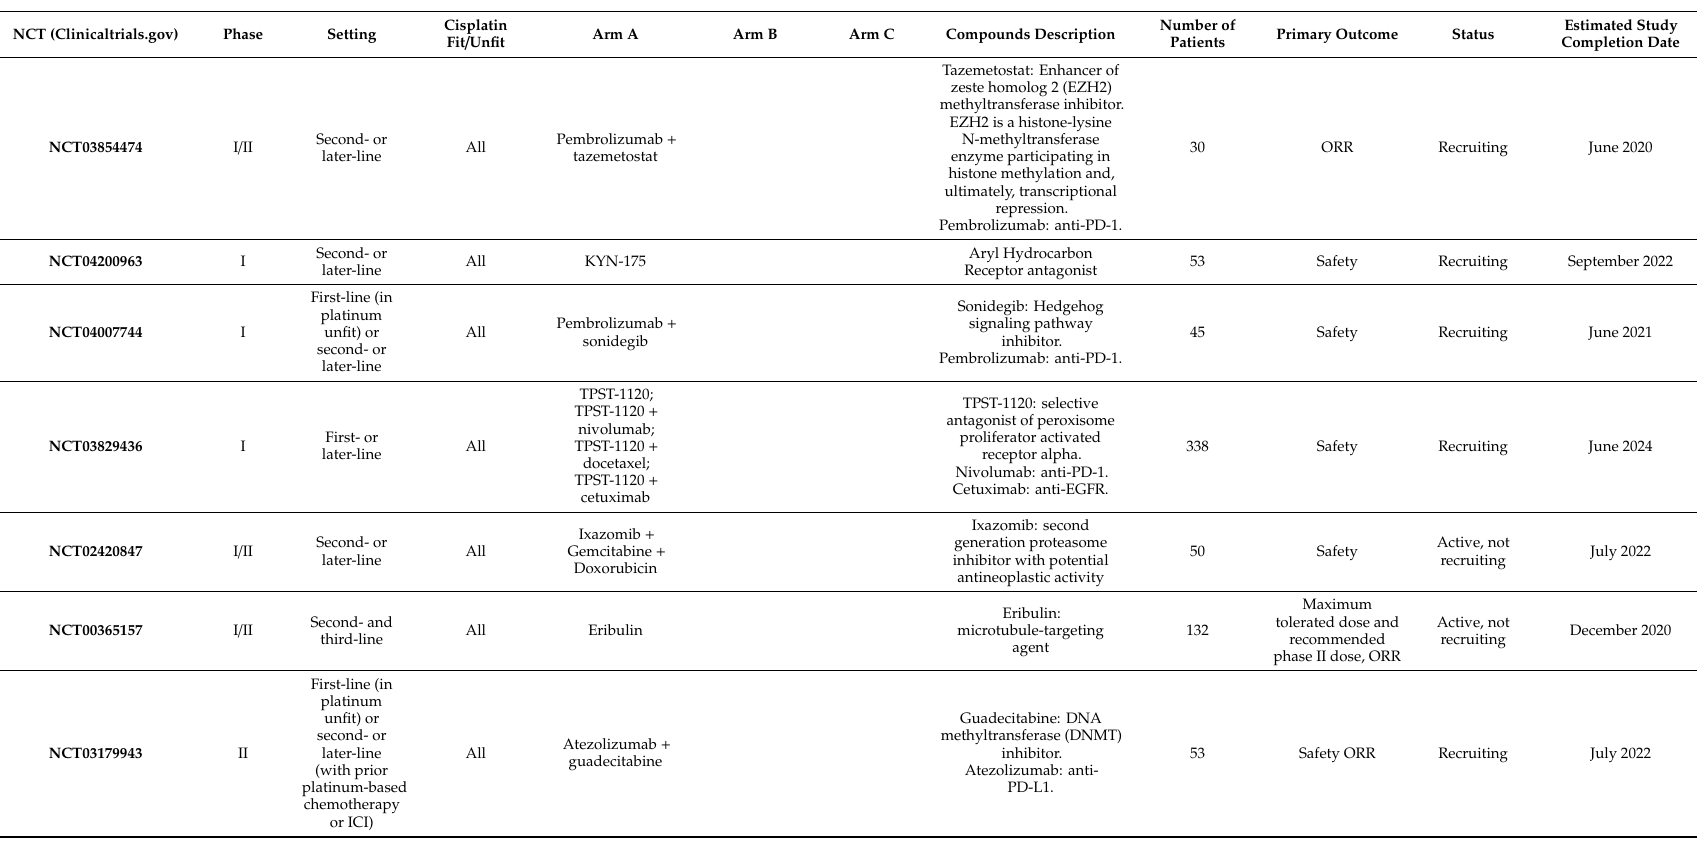
Table 8. Ongoing phase I / II / III trials of miscellanea therapies. ORR: overall response rate. PFS: progression-free survival. OS: overall survival. NCT